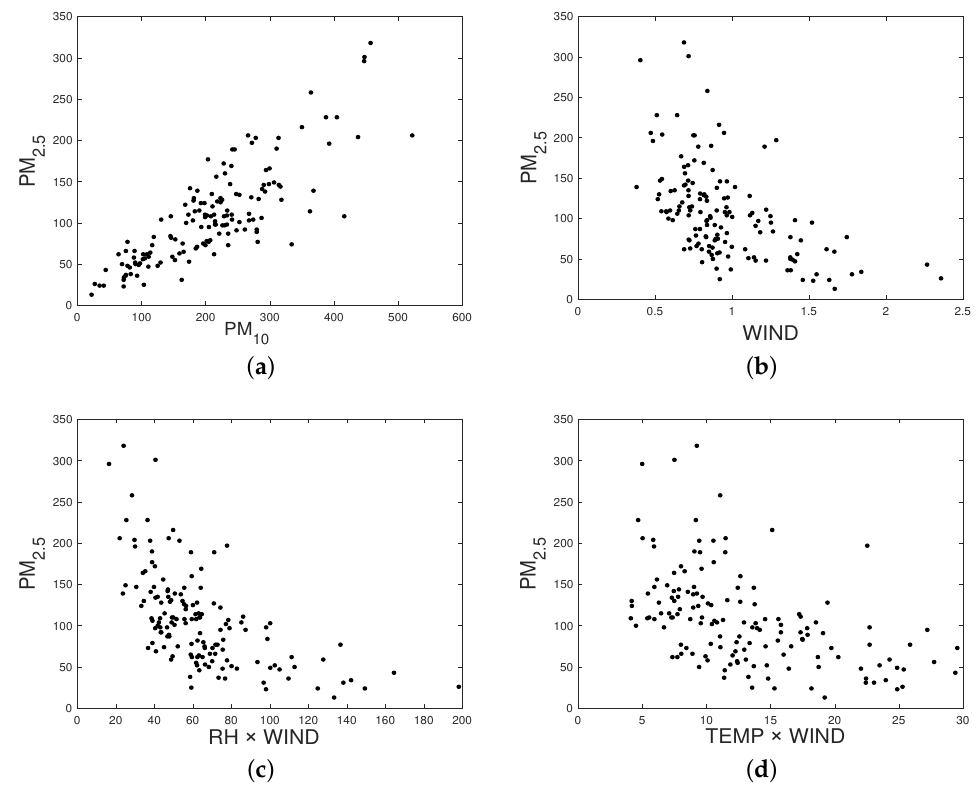
Figure 2. Scatter plots for ( a ) PM 2.5 v/s PM 10 , ( b ) PM 2.5 v/s WIND, ( c ) PM 2.5 v/s RH × WIND, and ( d ) PM 2.5 v/s TEMP ×